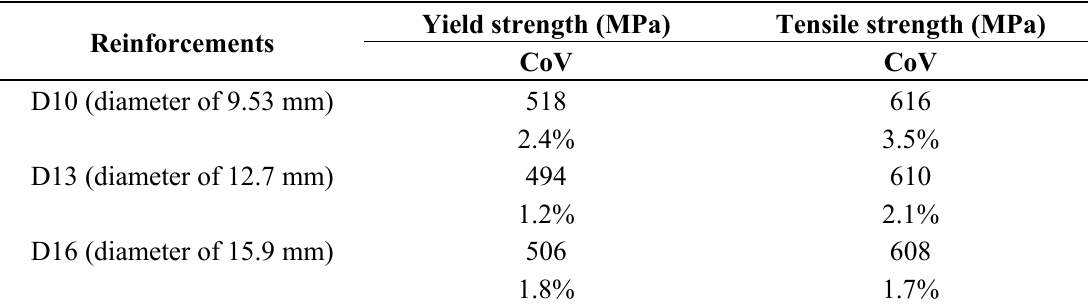
Table 3. Mechanical properties of deformed steel bars.